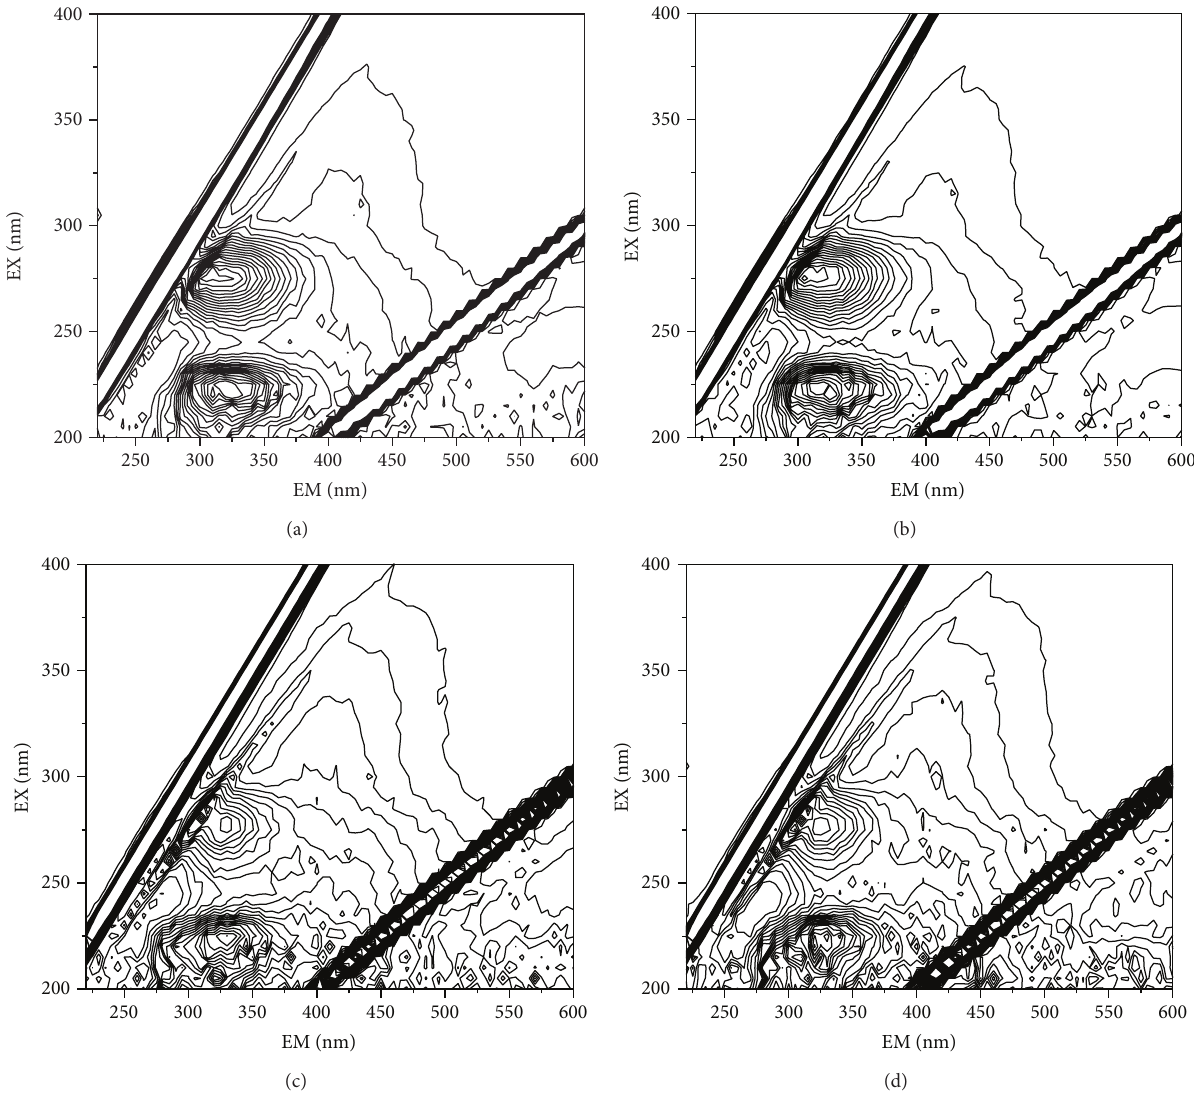
Figure 6: Three-dimensional fluorescence patterns demonstrating the removal of soluble organics by Fe 70 and liquid chlorine. ((a) Water sampled before chlorine disinfection; (b) water sampled after chlorine disinfection: chlorine dosage = 1.5mg/L, and reaction time = 30 min; (c) water treated by Fe 70 : dosage = 0.06 g/L, and reaction time = 10min; and (d) water treated by Fe 70 : dosage = 0.06 g/L, reaction time = 20